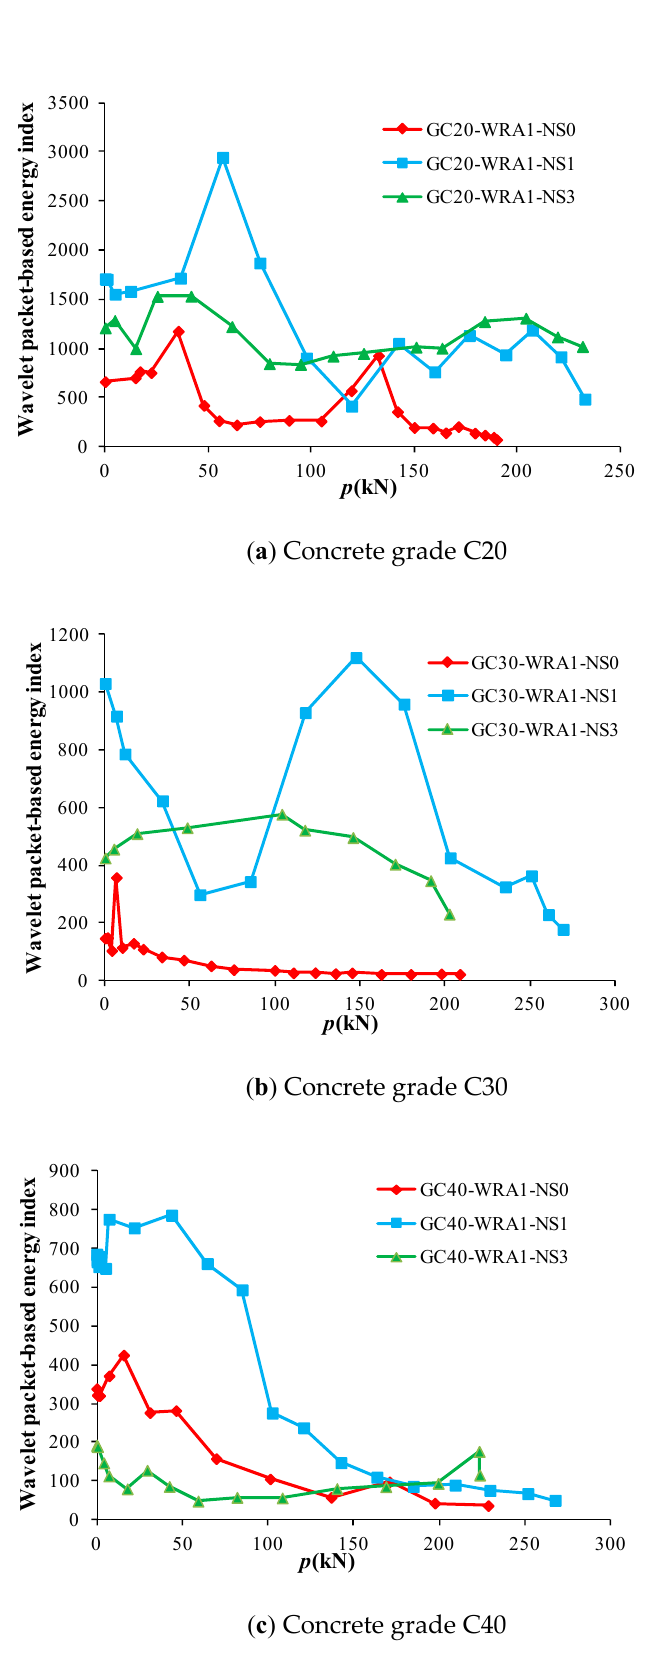
Figure 12. Load – energy index curves of superplasticizer-added specimens with different nano-SiO 2 Figure12. Load–energyindexcurvesofsuperplasticizer-addedspecimenswithdifferentnano-SiO 2